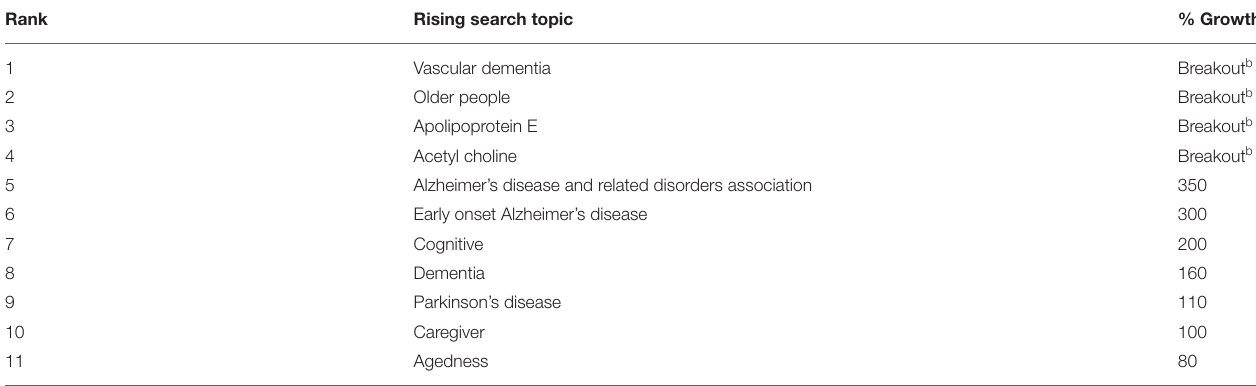
TABLE 1 | Relatively fast-growing topics regarding the term of “Alzheimer’s disease.”